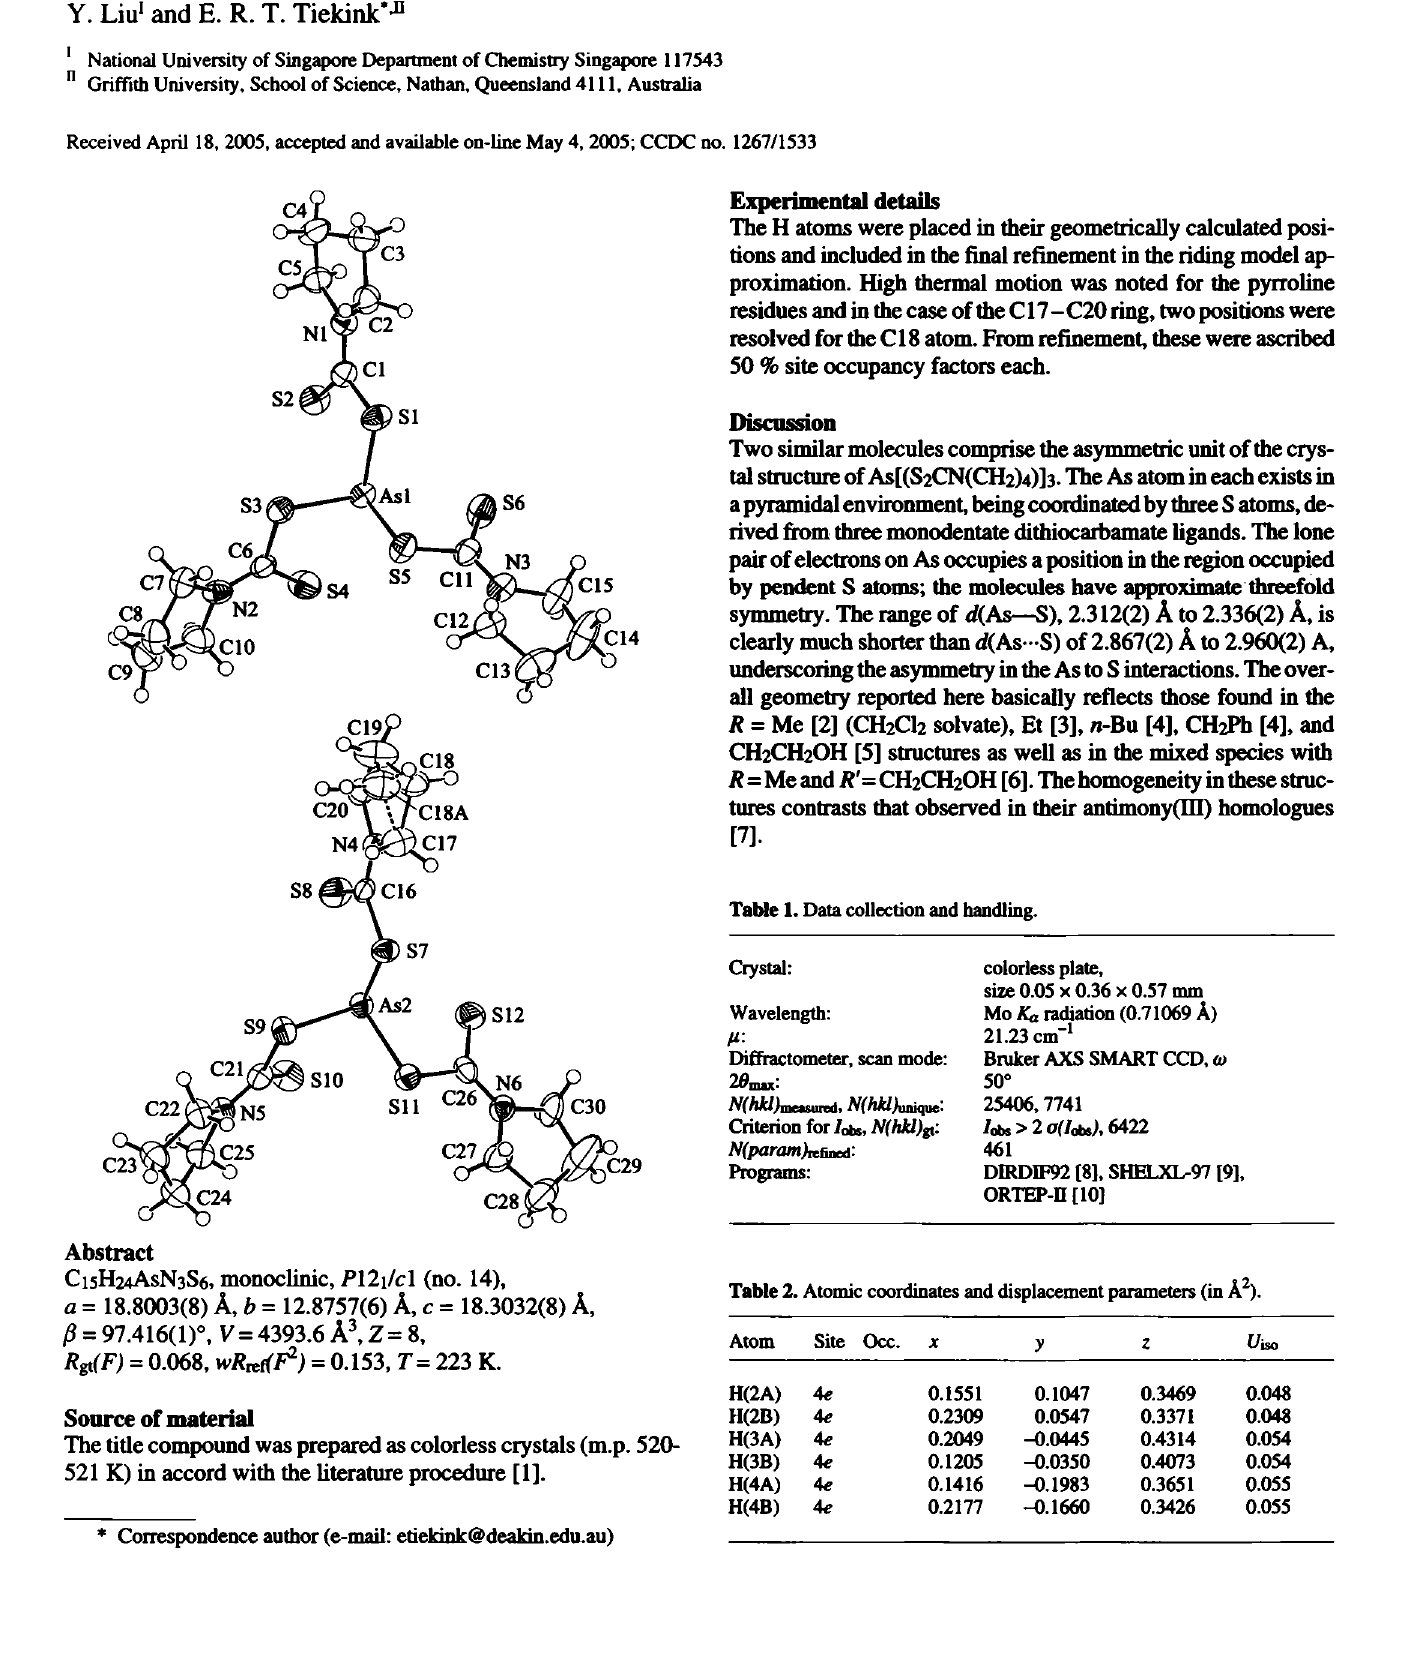
Table 2. Atomic coordinates and displacement parameters (in Ä 2